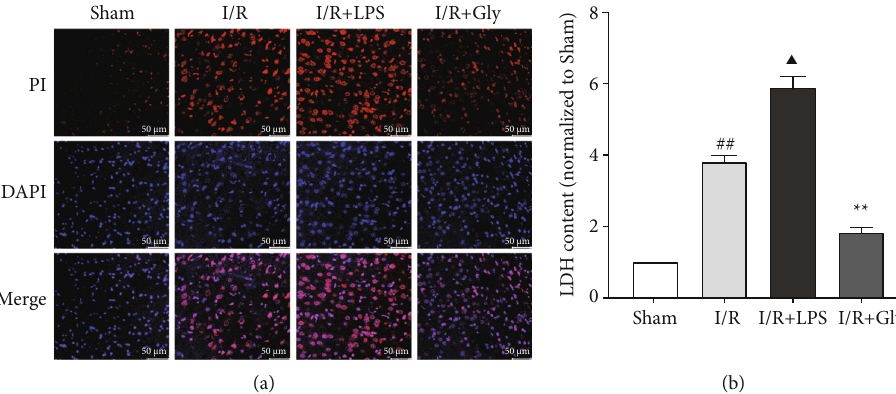
Figure 2: E ff ects of LPS and Gly interventions on the degree of pyroptosis at 24h after reperfusion. (a) Representative pictures of PI staining, the red dots represent positive PI staining; scale bars, 50 μ m. (b) Relevant quantitative analysis of LDH content, n = 4 . Data are presented as mean ± SD . ## P < 0 : 01 , I/R group versus sham group; ▲ P < 0 : 05 , I/R + LPS group versus I/R group; ∗∗ P < 0 : 01 , I/R +Gly group versus I/R